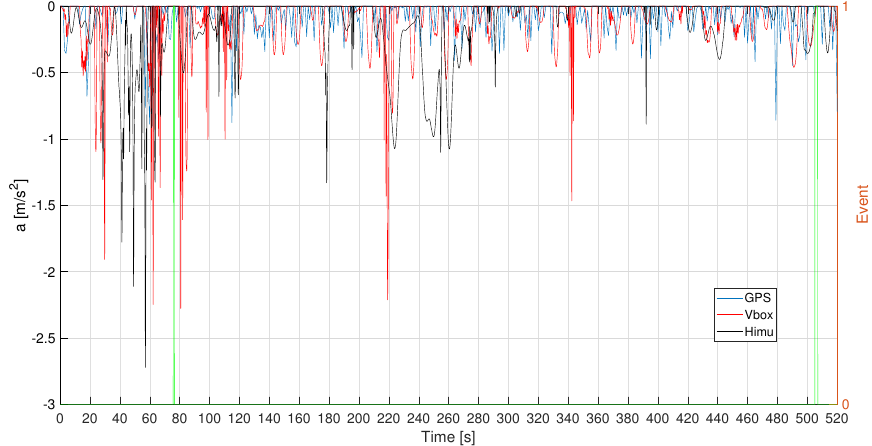
Figure 19. L1—Filtered acceleration signals. Events are reported as pulsed train (green solid